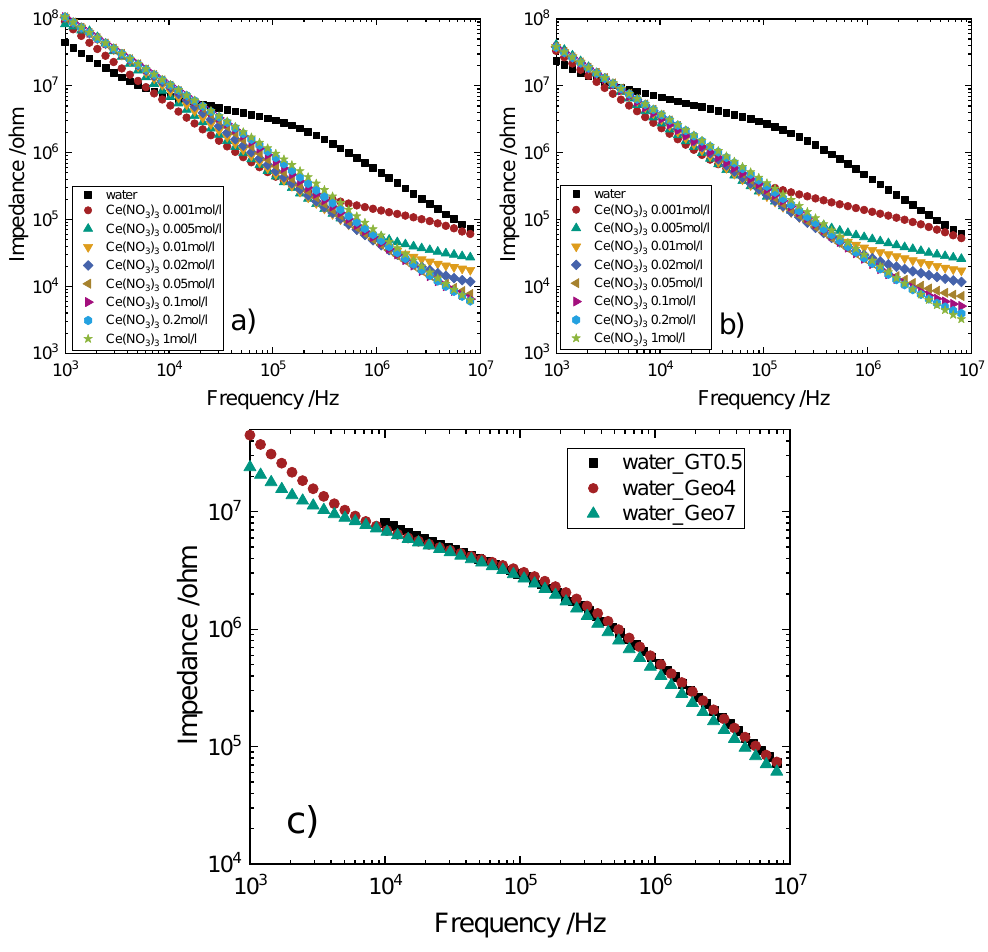
Figure 10. Impedance over frequency for deionized water and cerium nitrate with different con- centrations. ( a ) Geo4 with an electrode width of 10 mm and a distance of 5 mm, ( b ) Geo7 with an electrode width of 20 mm and a distance of 5 mm. At both electrode designs, alumina tube are used. ( c ) Comparison of water with different electrode geometries, see Table 2 and different tube materials. Black square, glass tube are used, red circles and green triangle alumina tube are